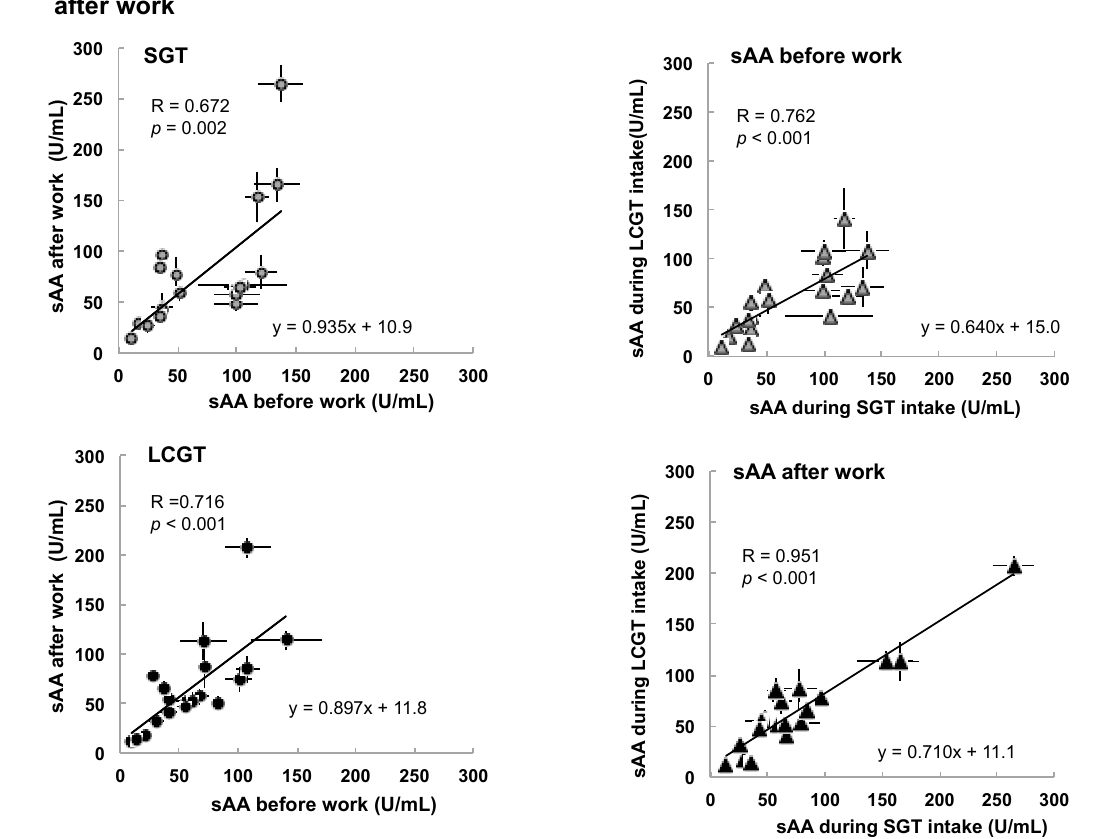
Figure 3. Level of sAA in each participant. ( a ) Correlation between sAA before and after work; ( b ) Correlation of sAA before or after work between during SGT and LCGT intake. Data are expressed as mean ± SEM ( n = 5, in each participant).